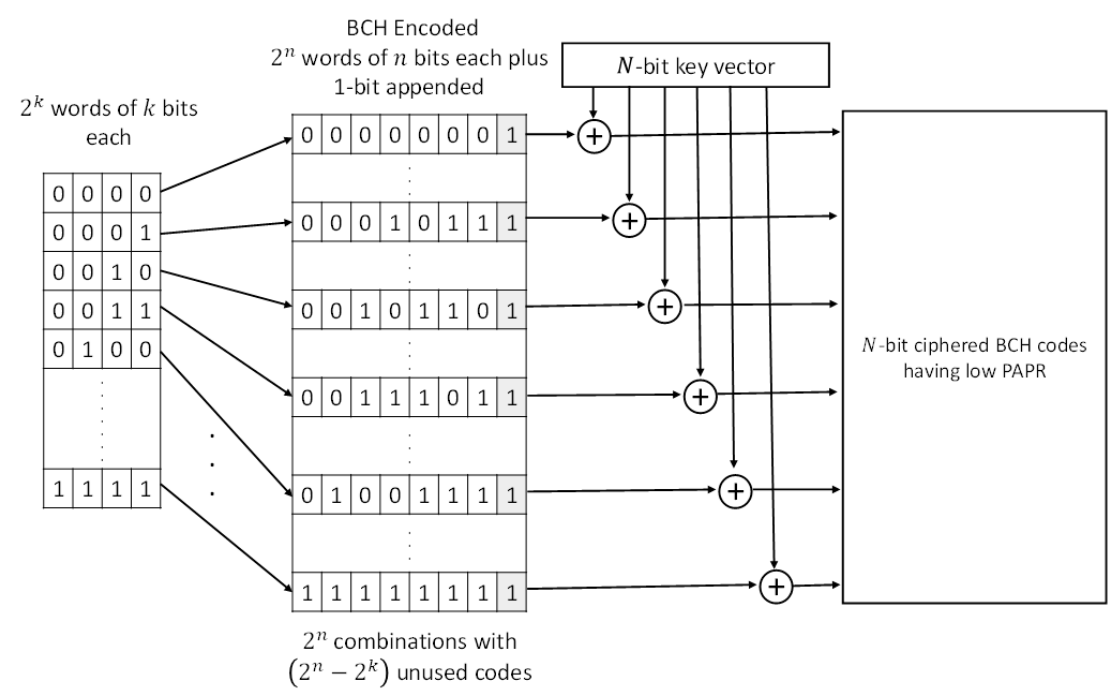
Figure 5. An example of the generation of ciphered BCH(n,k) codes for an 8 subcarrier OFDM system with k = 4, n = 7 .